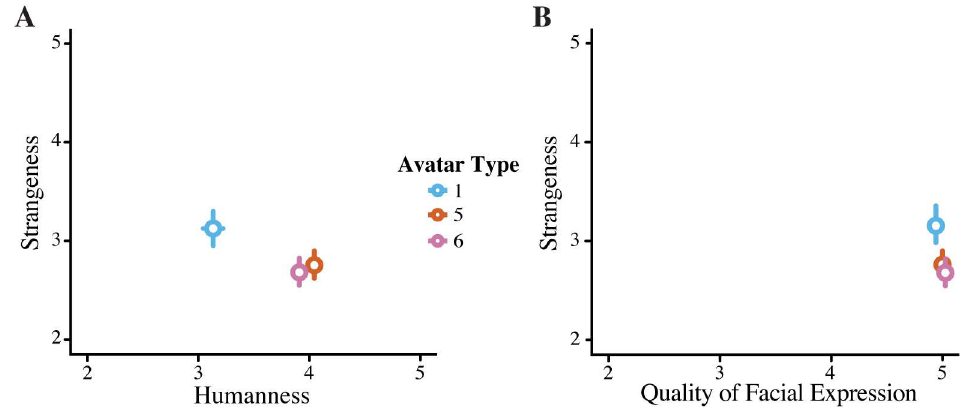
Fig 3. Rating of AvatarVersions for Experiment 2. A. Correlation between the strangeness and humanness ratings and B. Correlationbetweenstrangeness and quality of facial expressions for the three avatars. Error bars represent standarderror.